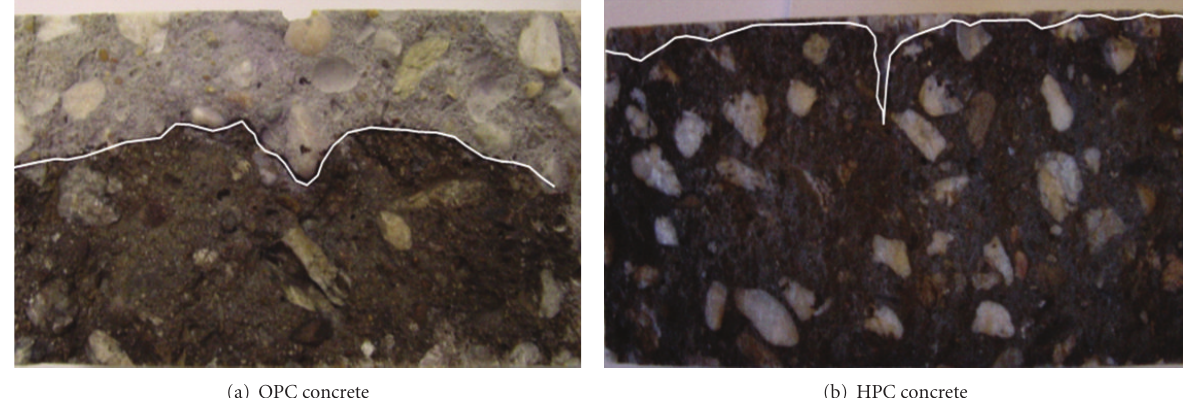
Figure 10: Comparison of chloride profile of OPC concrete with that of HPC concrete.